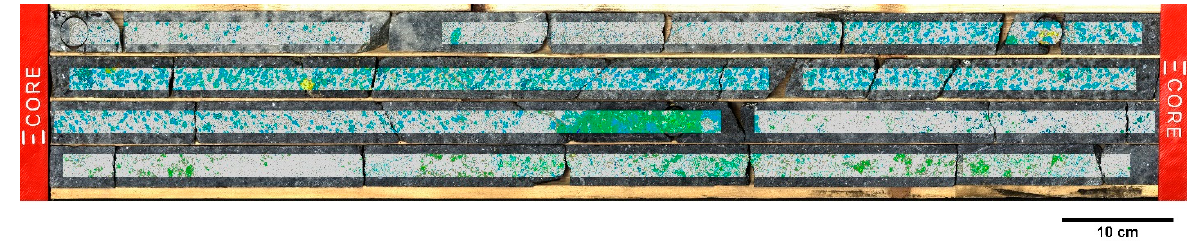
Figure 7. LIBS mineral mapping of a full core tray at a spatial resolution of 50 µm and a step size of 100 µm overlay on the high-resolution image of the core tray. The color code is the same as in Figure 6.